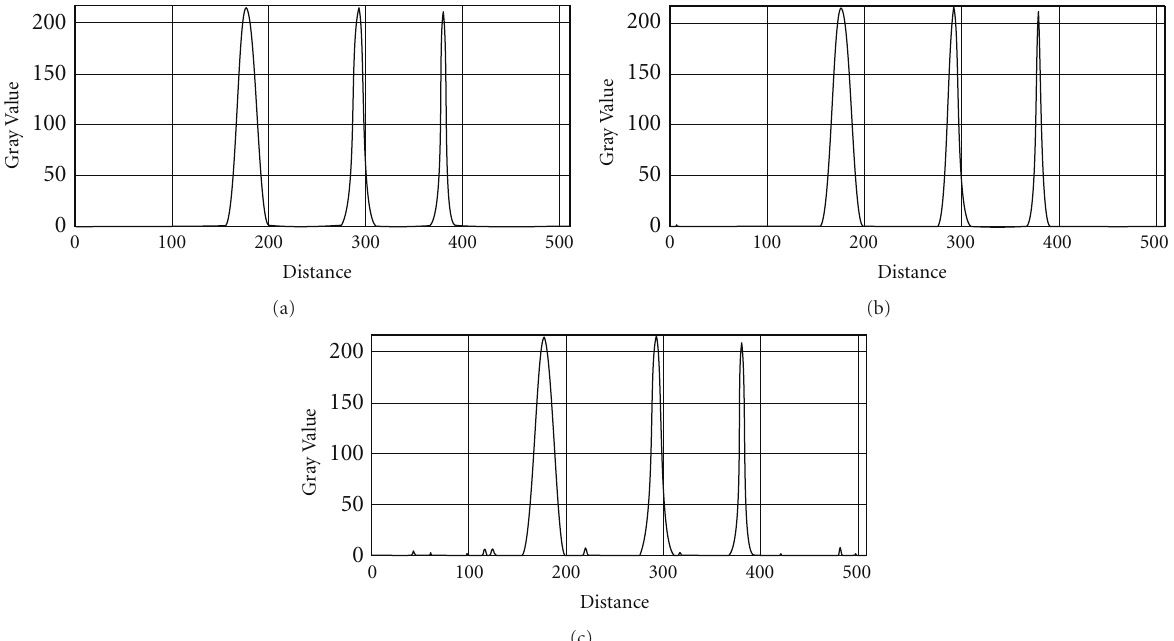
Figure 11: Intensity profiles across the tubular objects with Gaussian intensity profiles in the processed images with various polynomial noisy backgrounds added. (a) Noise SD = 0; (b) SD = 25; (c) SD = 50.